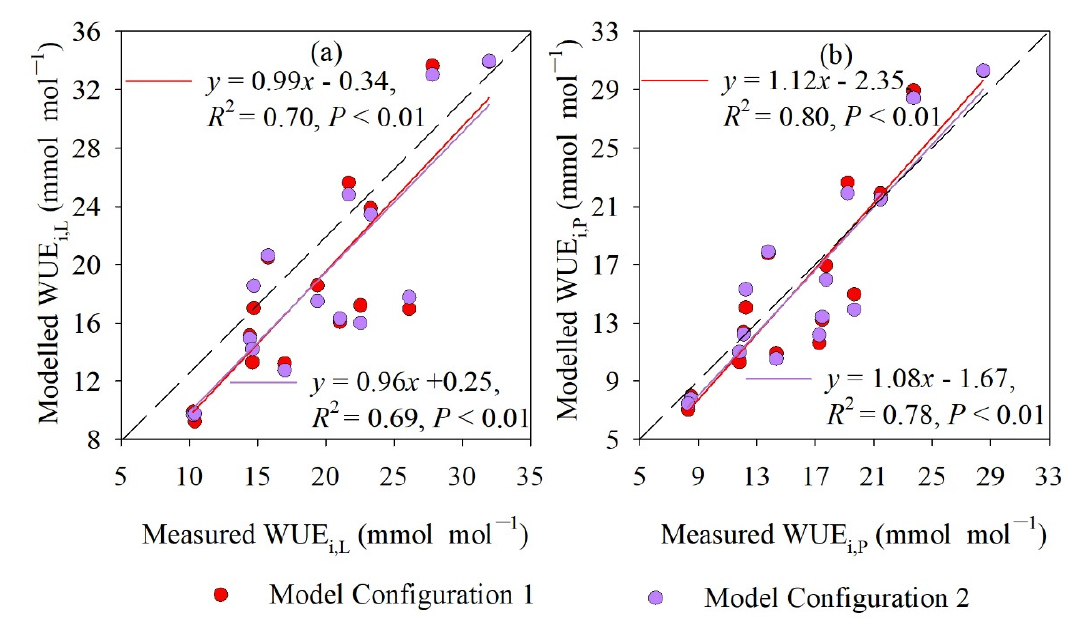
Figure 7. Correlation analysis between measured and modeled results of leaf instantaneous water use efficiency (WUE i-L , mmol·mol − 1 ) estimated by different model configurations ( a ), as well as between measured and modeled results of whole-plant instantaneous water use efficiency (WUE i-P , mmol·mol − 1 ) estimated by different model configurations ( b ).